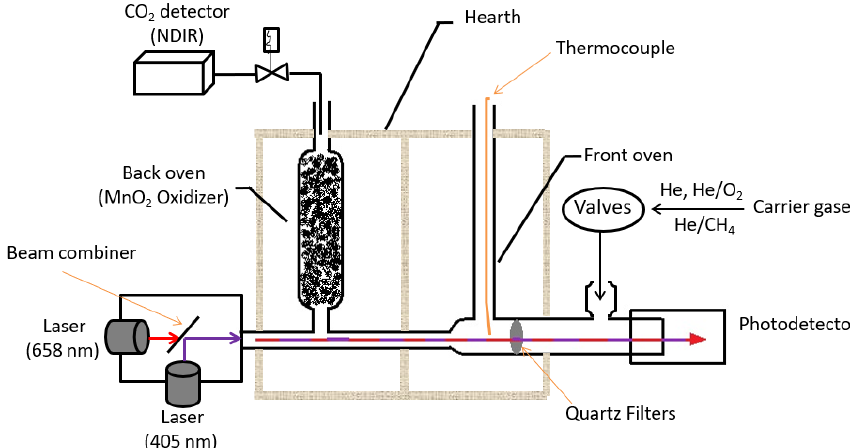
Figure 1. Principle and structure of the Sunset semi-continuous carbon analyzer.